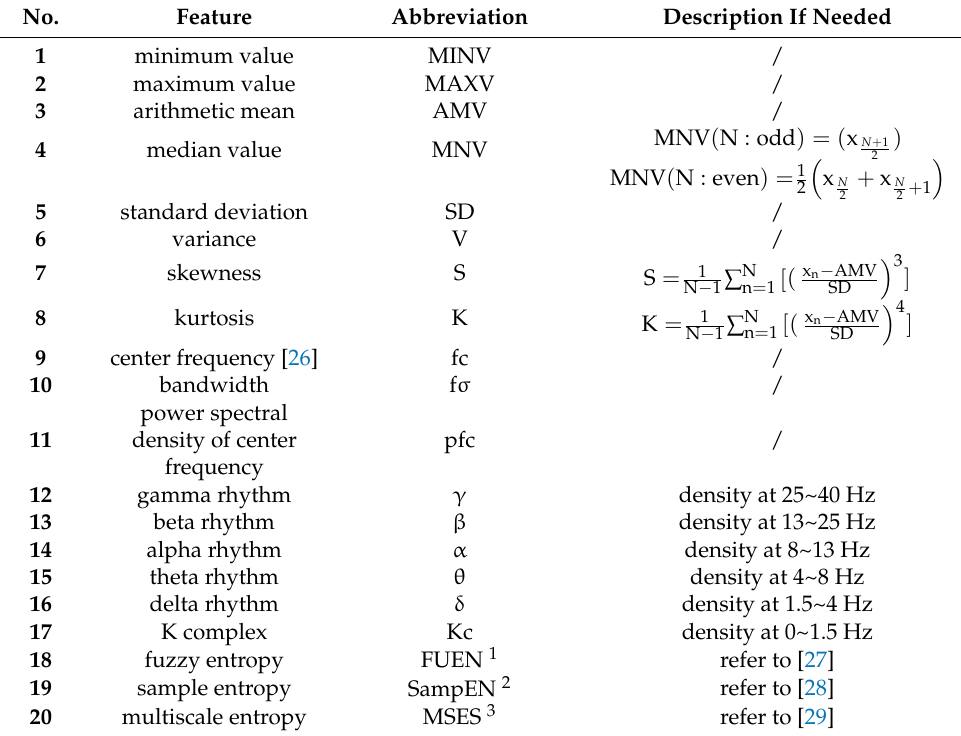
Table 1. Extracted features derived in an